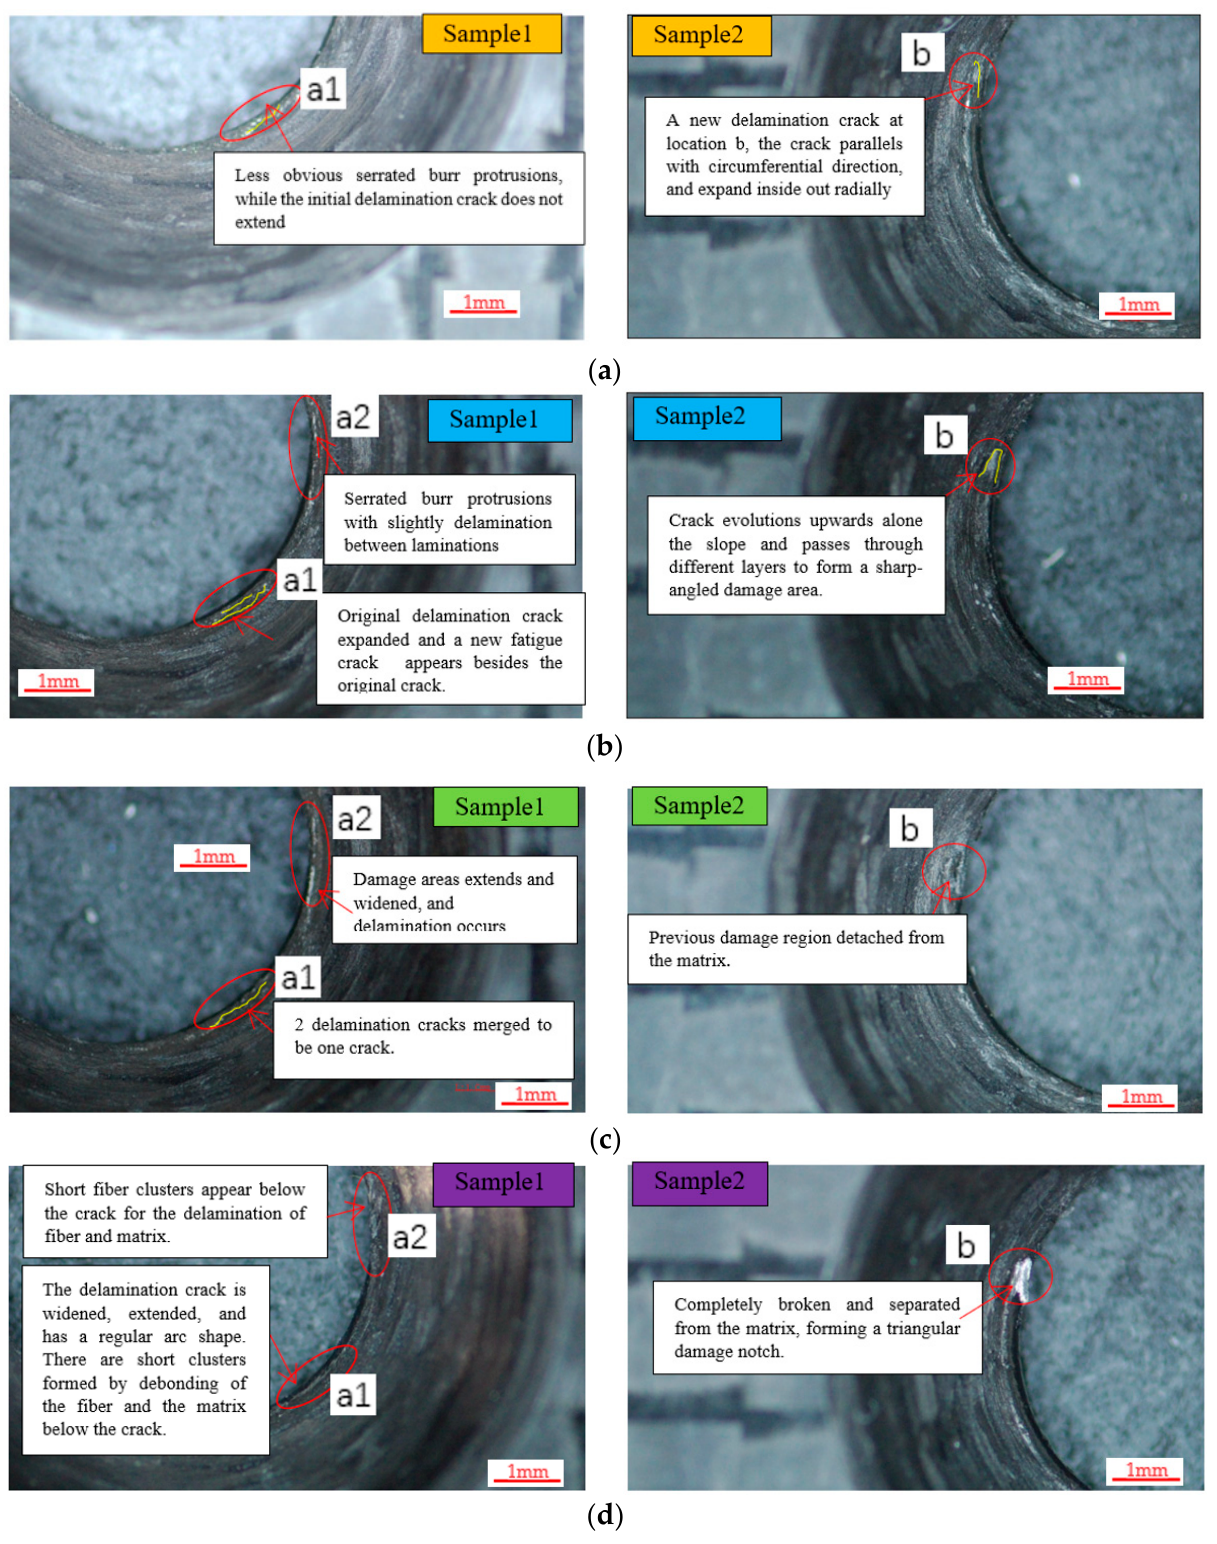
Figure 4. Fatigue damage. ( a ) Fatigue damage after 10 3 cycles of loading. ( b ) Fatigue damage after 10 4 cycles of loading. ( c ) Fatigue damage after 10 5 cycles of loading. ( d ) Fatigue damage after 10 6 cycles of loading.